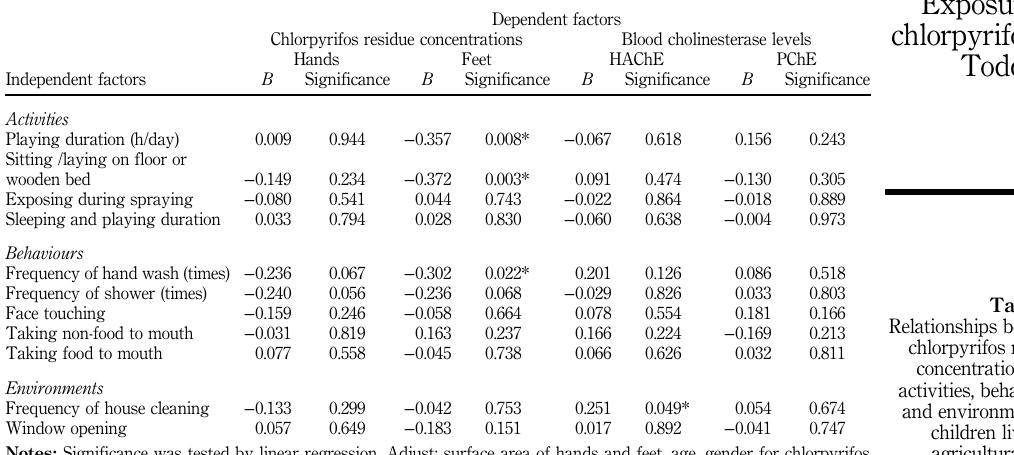
Table V. Relationships between